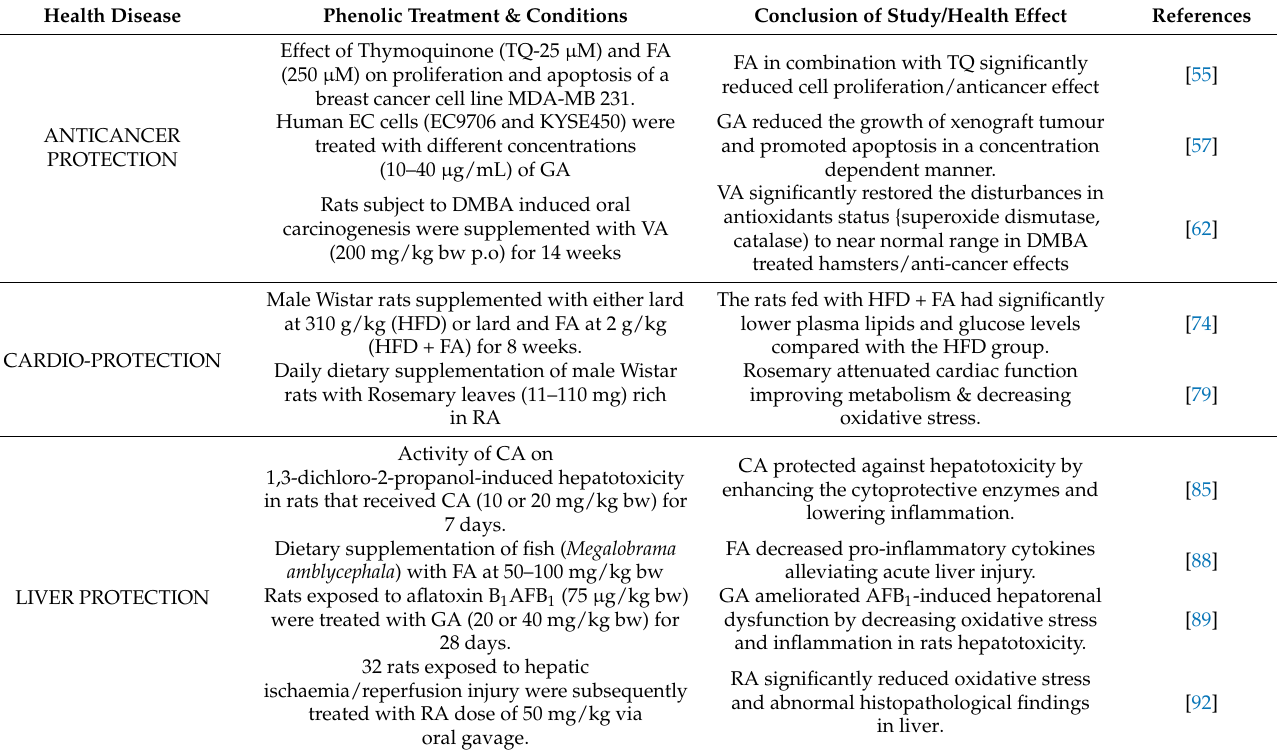
Table 1. Selection of in vivo and in vitro studies on the health/biochemical properties of various phenolic acids. Health Disease Phenolic Treatment & Conditions